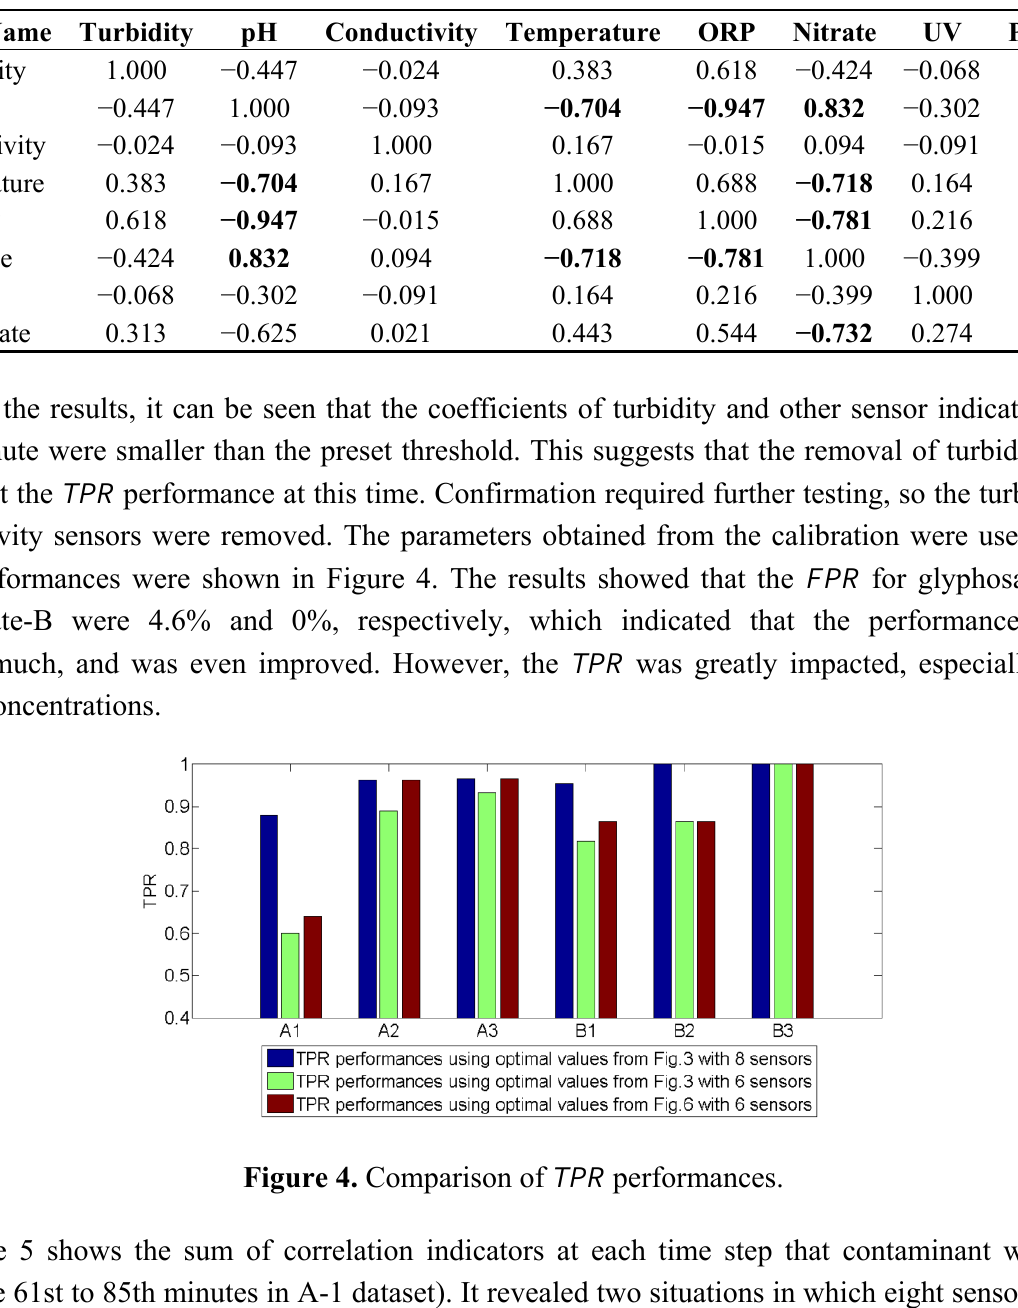
Table 4. Correlation coefficients (contamination).